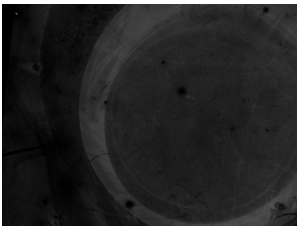
Figure A3. Image by epifluorescence microscopy corresponding to the hybridization of the Sequence 2 probe with its complementary strand, performed 17 months after the probe grafting. The analysis was carried out on Si/SiO 2 (100 nm) substrates functionalized by UV-assisted GOPS protocol, using an exposure time of 3 s.